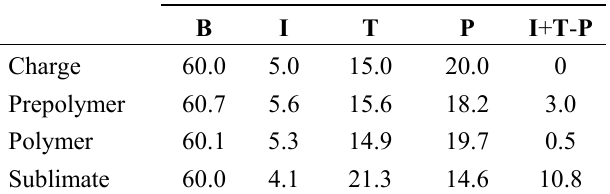
Table 9. Mole percentages for a sublimate from an LP lab preparation by NaOD/D NMR